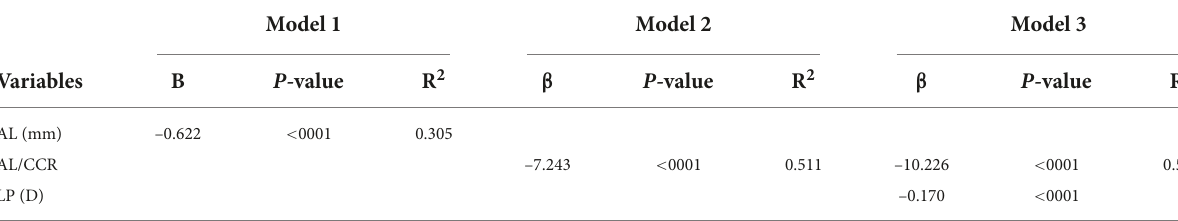
TABLE 3 Linear regression models for spherical equivalent refraction (SER) with axial length (AL), AL/corneal curvature radius (CCR), and lens power